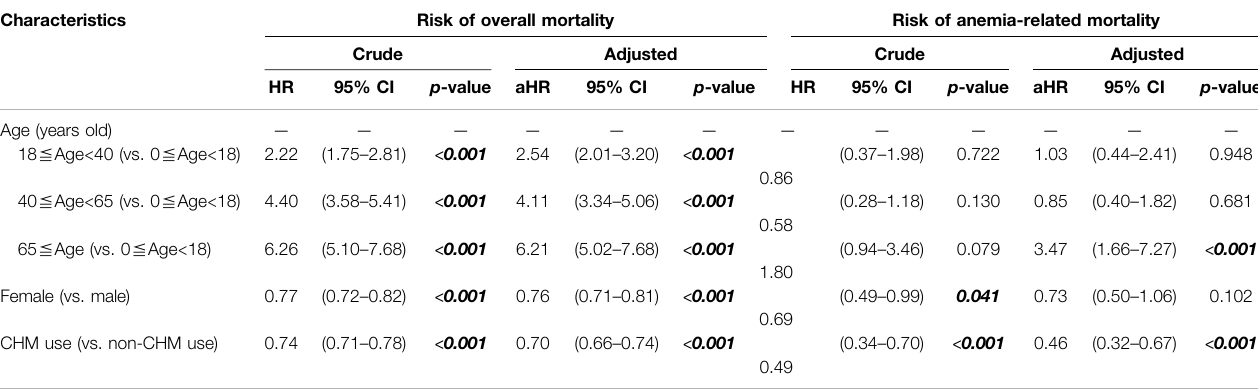
TABLE 4 | Cox proportional hazard models for risk of overall and anemia-related mortalites in patients with aplastic anemia.